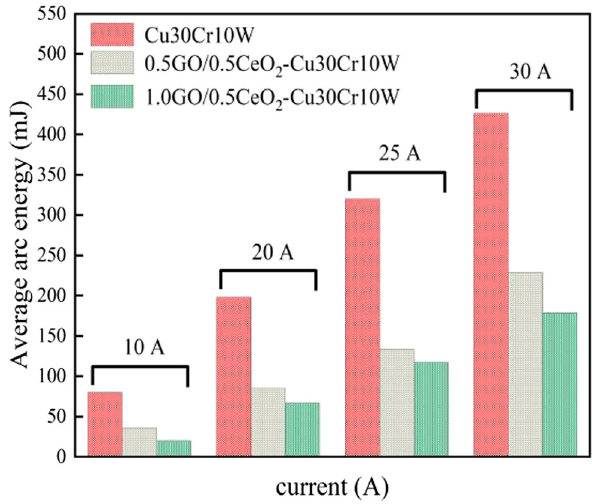
Figure 11: Arc burning energy of composite